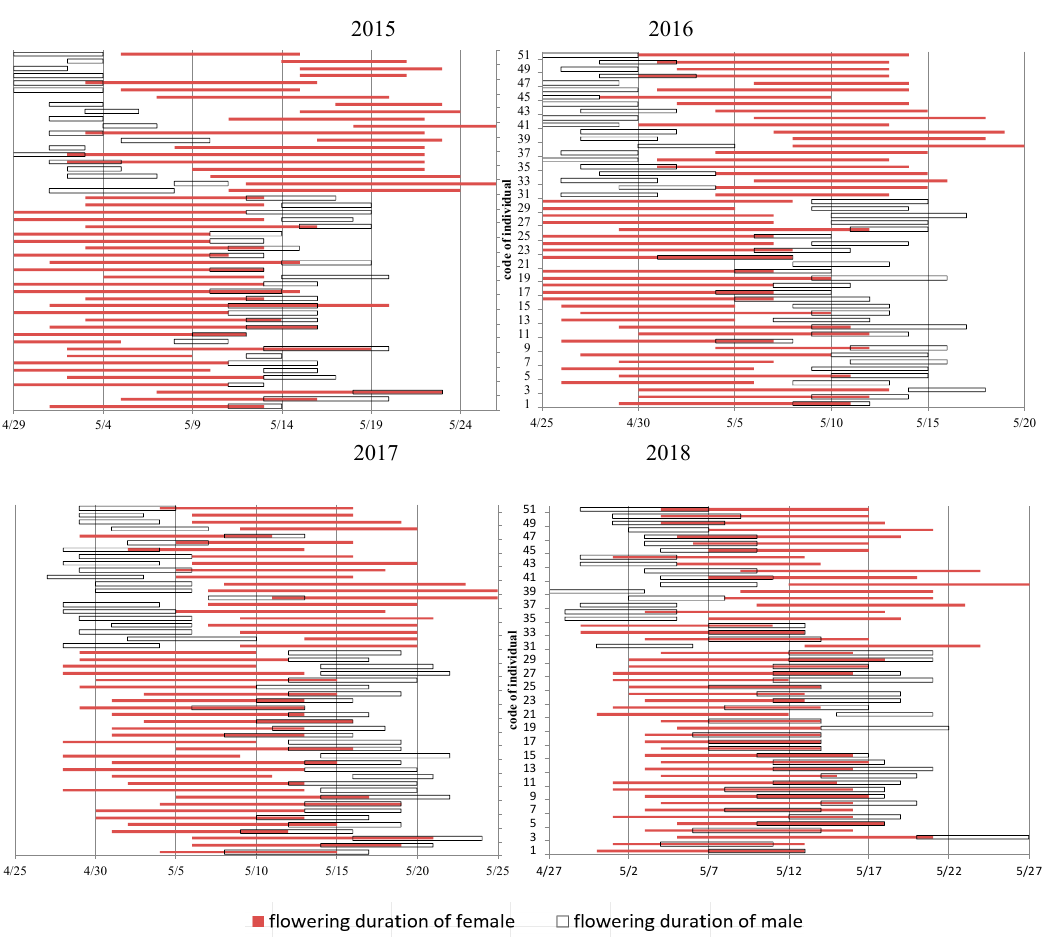
Figure 3. Flowering phenology of males and females within individuals based on 21PA and 30PG trees of C. paliurus during 2015–2018.